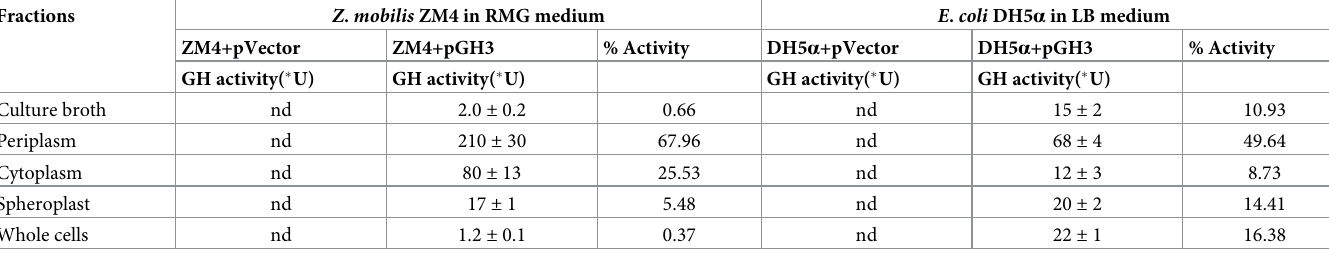
� U, relative fluorescence signal produced per μ g of protein per min. nd, not detectable. RMG, rich medium glucose. LB, Luria-Bertani. Percentage activity was calculated from the ratio of activity of each fraction with respect to the total activity of all